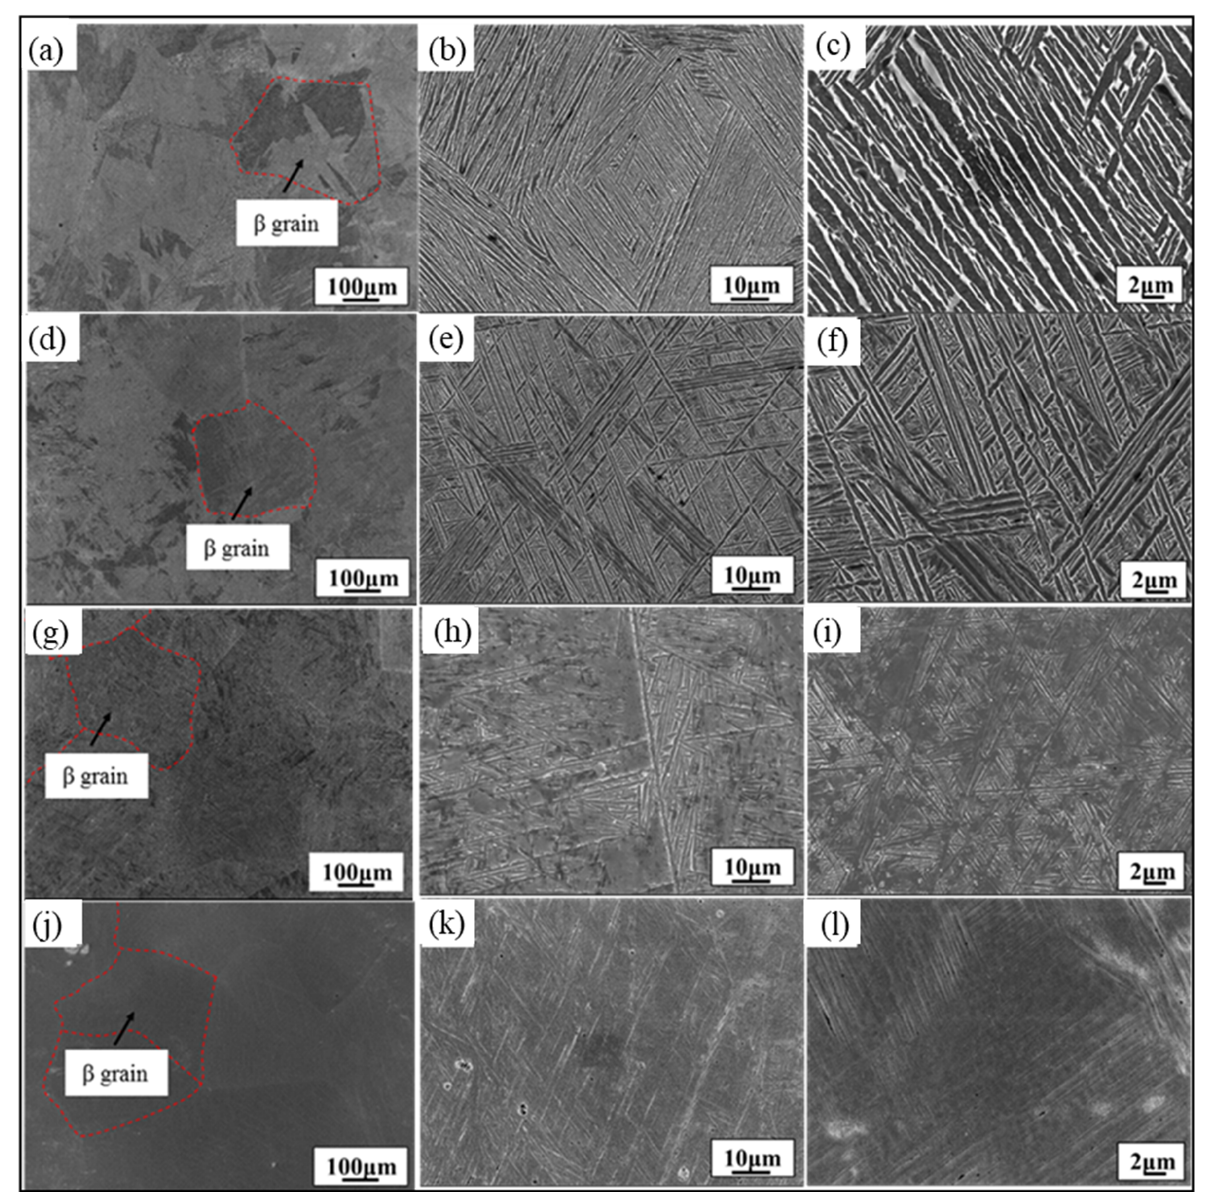
Figure 2. Microstructure of different cooling methods: ( a – c ) FC; ( d – f ) OFC; ( g – i ) AC; and ( j – l ) WQ. Table 1. Microstructure parameters of TC21 alloy at different cooling methods ( μ m).